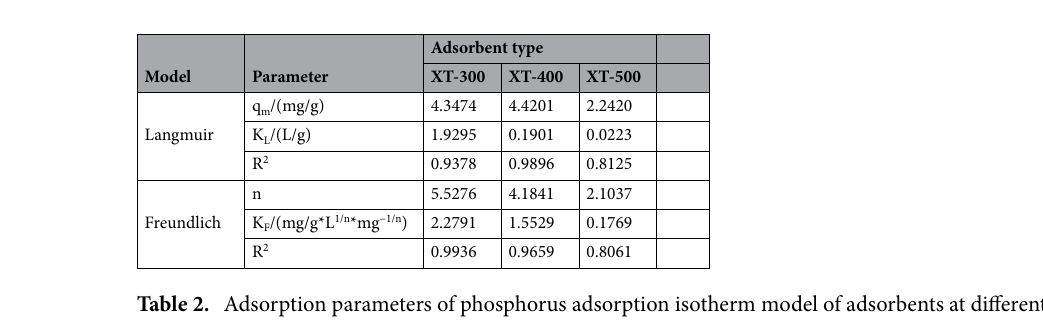
Table 2. Adsorption parameters of phosphorus adsorption isotherm model of adsorbents at different temperatures.